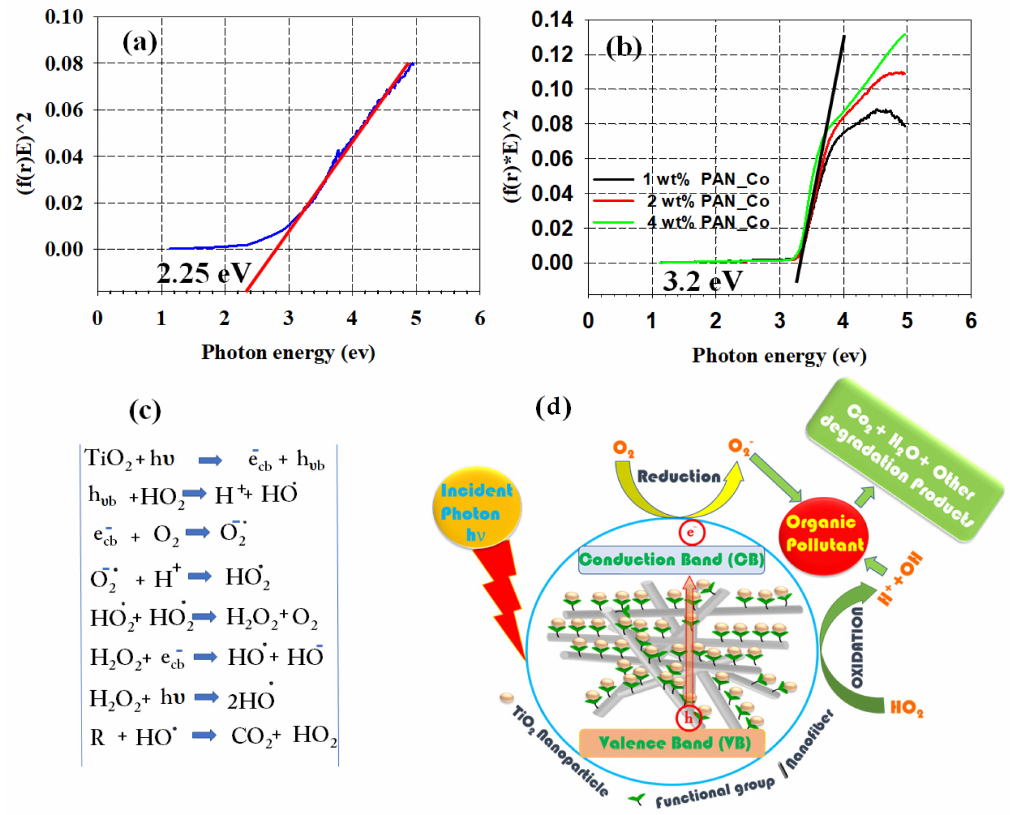
Figure 10. T-plots of the energy band gap ( a ) PAN_Coa, ( b ) PAN_Co, ( c ) reactions during photodegradation of the pollutant and ( d ) schematic of the photocatalysis process. The wt% shows the content of TiO 2 NPs in the PAN_Co NFs mem- brane.